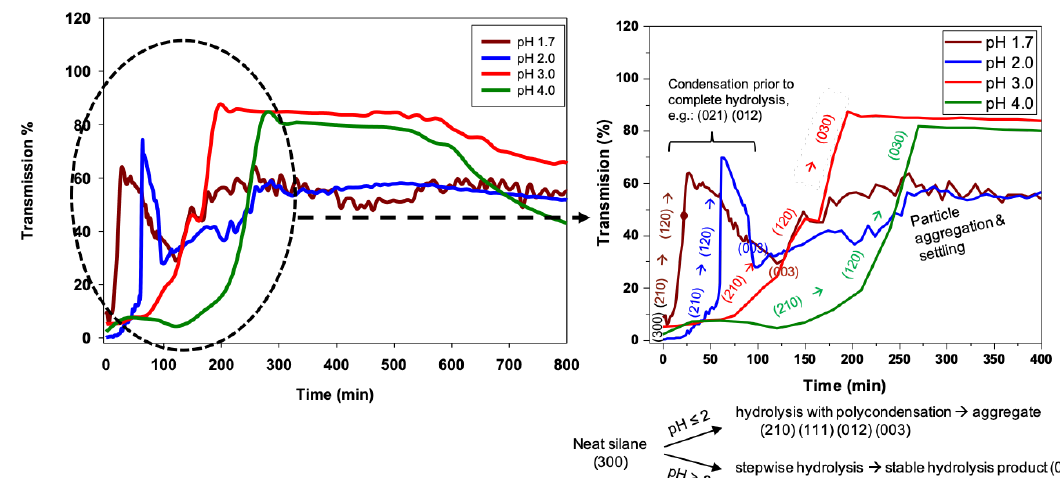
Figure 7. Hydrolysis and condensation kinetics of 3F (0.4 M) based on transmissivity, using Turbiscan-analyzed data at pH 1.7, 2.0, 3.0, and 4.0. Transmissivity data for different pH are taken at the height where transmissivity is the lowest at the beginning due to the presence of 3F. A zoomed figure in the right shows how the chemical transformation occurred in 3F during the hydrolysis and condensation process. Table 1. Summary of the average hydrolysis, condensation, sedimental time, and stability of the hydrolyzed state at pH 1.7, 2.0, 3.0, and 4.0 of nPM and 3F. Average Average Average Condensation Stability of pH Condensation Sedimentation Hydrolysis Time Starting Time Hydrolyzed State Time